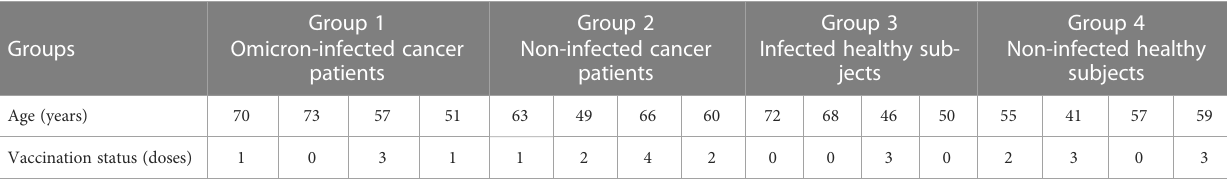
TABLE 1 Vaccination status of 16 subjects.